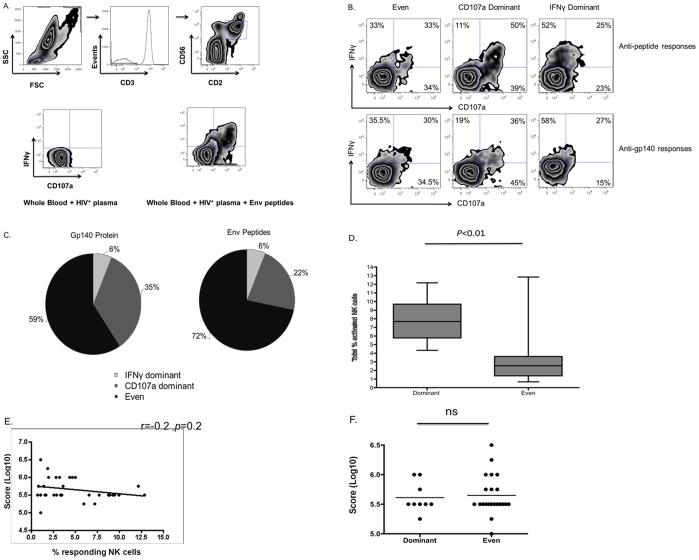
Differential NK cell activation patterns by HIV-specific ADCC.The ability of NK cells to respond to anti-HIV ADCC antibodies was assessed using a flow-based assay. (A) Stimulated cells were stained with fluorochrome conjugated antibodies against CD3, CD2, CD56, CD107a and IFNγ. After collection on a FACS II Canto, lymphocytes were gated upon and NK cells were identified as CD3−CD2+CD56+. Cells within the NK cell population were assessed for IFNγ production and CD107a expression prior to and following activation. (B) Zebra plots depict examples of the diverse anti-HIV ADCC responses obtained when NK cells from a common donor are stimulated with sera from different HIV-infected individuals in the presence of Env peptides (top) or gp140 protein (bottom). The numbers in the quadrants represent the percentages of responding NK cells that are mediating IFNγ+CD107a−, IFNγ−CD107a+ and IFNγ+CD107a+ responses. (C) The pie chart on the left illustrates the frequency with which IFNγ dominant, CD107a dominant and even response profiles were observed, when sera samples from 32 HIV-infected individuals were used to stimulate NK cells from a common donor in the presence of gp140 protein. The pie chart on the right depicts the same analysis for stimulation with Env peptides. (D) The box and whiskers plot depicts the assessment of the relationship between the ability of different sera to induce diverse anti-HIV ADCC functional profiles against HIV gp140 and the magnitude of the total ADCC response. The total percent of NK cell activation was compared between sera that induced “even” or “skewed” ADCC responses, using a T-test. (E) The scatter plot illustrates the relationship between the levels of sera anti-HIV gp140 IgG and the percent of total NK cells, from a common donor, activated by the sera in the whole blood ADCC assay in the presence of gp140. This correlation was assessed with the Spearman correlation. (F) The scatter plot depicts the assessment of the impact of the level of sera-associated anti-HIV gp140 IgG on the functional profile induced by different sera, evaluated by a T-test.